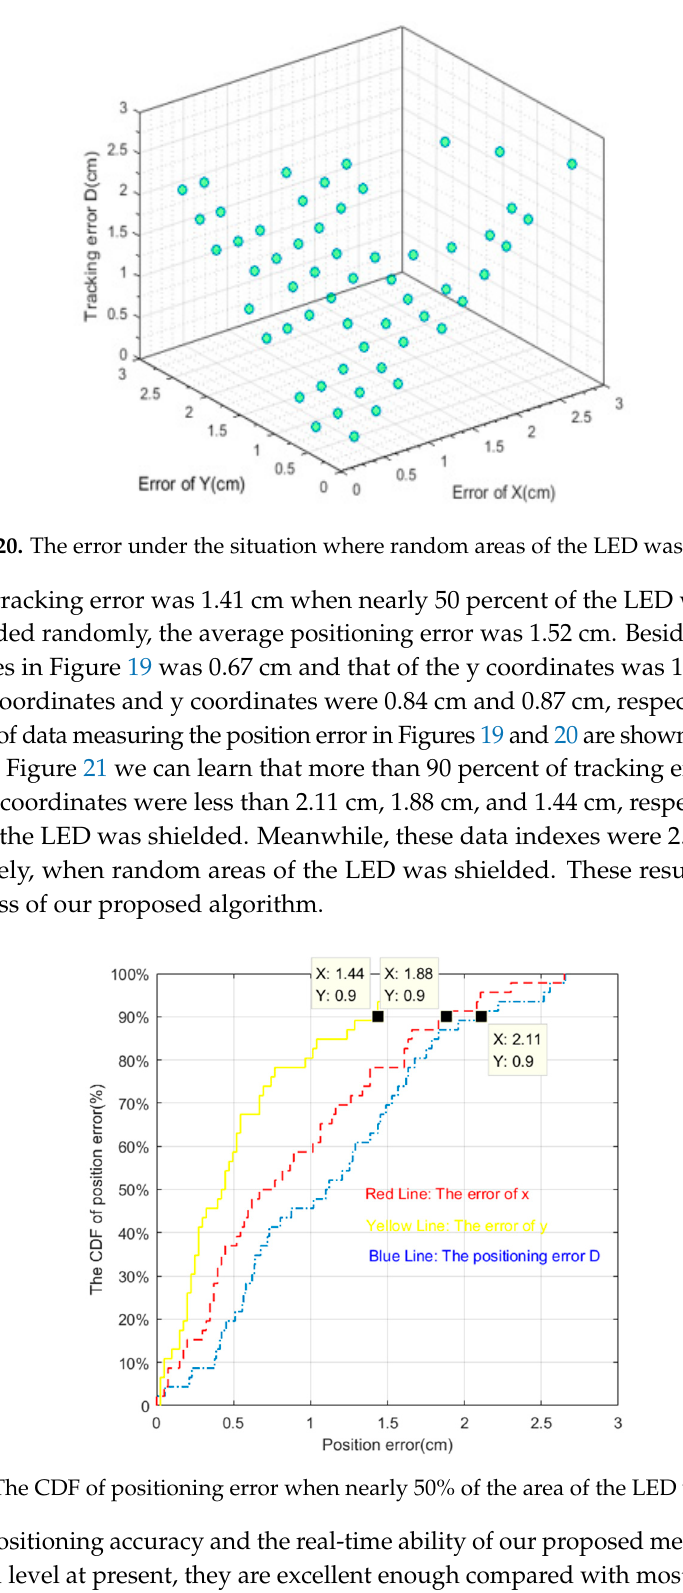
Figure 21. The CDF of positioning error when nearly 50% of the area of the LED was shielded.